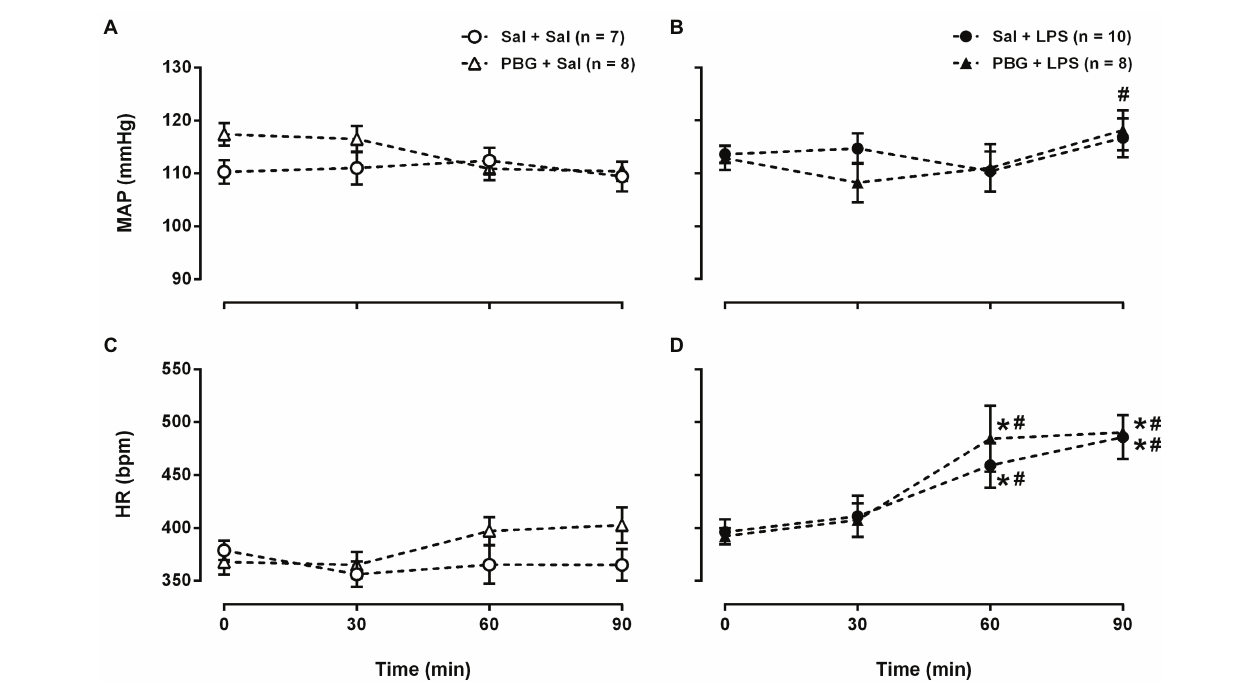
FIGURE 2 | Time course of hemodynamic response to phenylbiguanide and LPS. Mean arterial pressure [MAP (A) and (B) ] and heart rate [HR (C) and (D) ] at baseline (time zero), 30, 60, and 90 min after the administration of LPS or saline from the different groups. LPS, lipopolysaccharide; PBG, phenylbiguanide; and Sal, saline. * p < 0.05 vs. 0 min; # p < 0.05 vs. 30 min. Two-way ANOVA for repeated measures with Tukey’s post-hoc